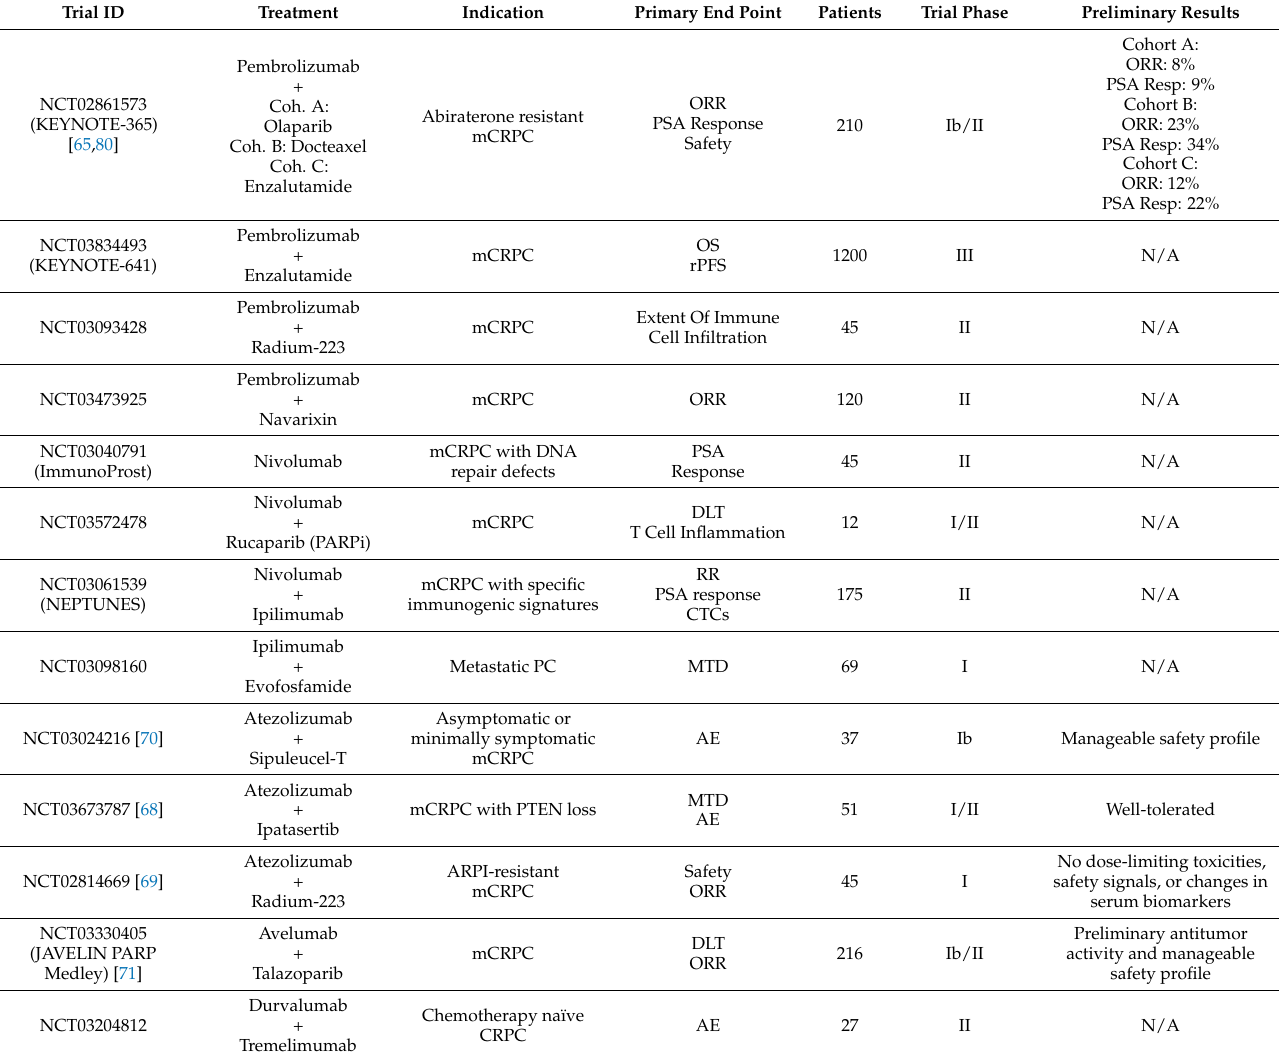
Table 2. Summary of ongoing clinical trials evaluating the efficacy of ICIs in monotherapy and in combination with other treatments in mCRPC. AE: adverse events; DLT: dose limiting toxicities; MTD: maximum tolerated dose; ORR: overall response rate; OS: overall survival; PFS: progression-free survival; rPFS : radiographic progression-free survival; RP: radiographic